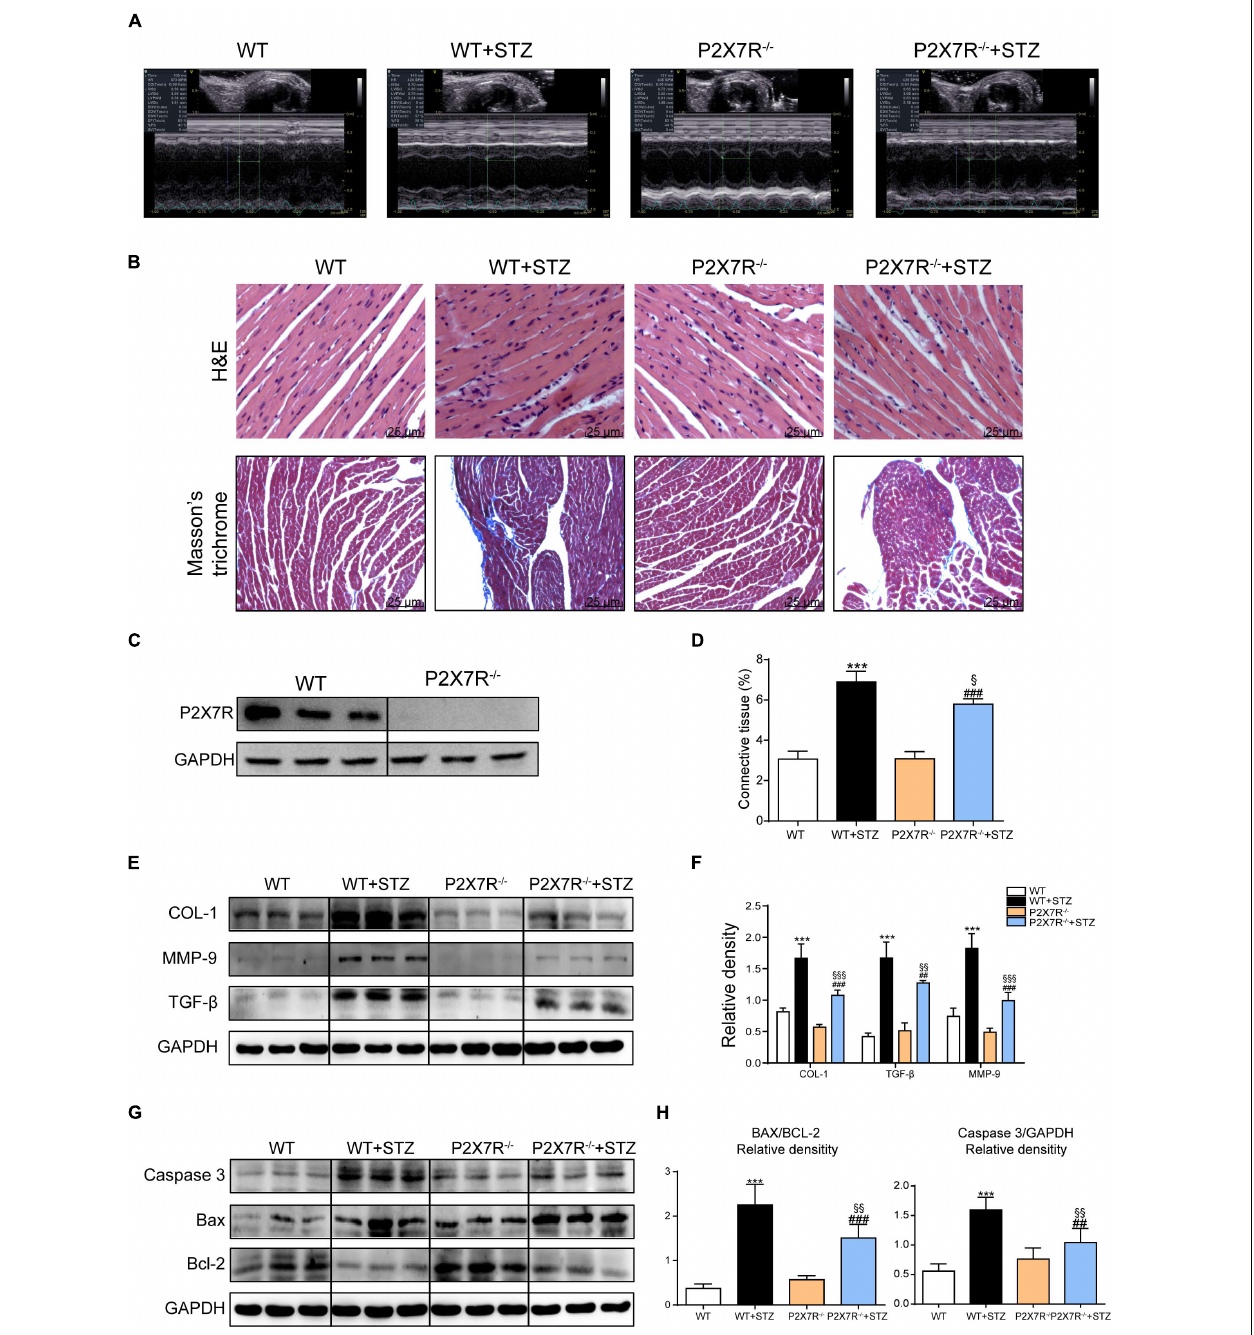
FIGURE 5 | The P2X7 receptor was involved in STZ-induced cardiac damage. Representative images (A) of echocardiograms from each group of knockout mice. Representative images of hematoxylin-eosin staining (H&E) of the myocardial tissues from knockout mice (400 × magnification), ( B , upper panel). Myocardial fibrosis was analyzed using Masson’s trichrome staining, and representative images ( B , bottom panel) are shown (400 × magnification). Quantification of the interstitial fibrotic areas (%) in images of Masson’s trichrome staining are shown in the bar graph (D) . The expression of the P2X7 receptor in myocardial tissues from knockout mice (C) . The protein levels of fibrosis markers in myocardial tissues were measured using western blotting (E,F) ( n = 3 animals per group). The levels of the apoptosis-related proteins Caspase-3, Bcl-2, and Bax were measured using western blotting (G) . The ratio of the Bcl-2 protein to the Bax protein and the ratio of Caspase3/GAPDH proteins are shown (H) . (Data from three independent experiments were analyzed: * p < 0.05, ** p < 0.01, and *** p < 0.001 compared with WT mice; # p < 0.05, ## p < 0.01, and ### p < 0.001 compared with P2X7R–/– mice; § p < 0.05, §§ p < 0.01, and §§§ p < 0.001 compared to the WT + STZ group).